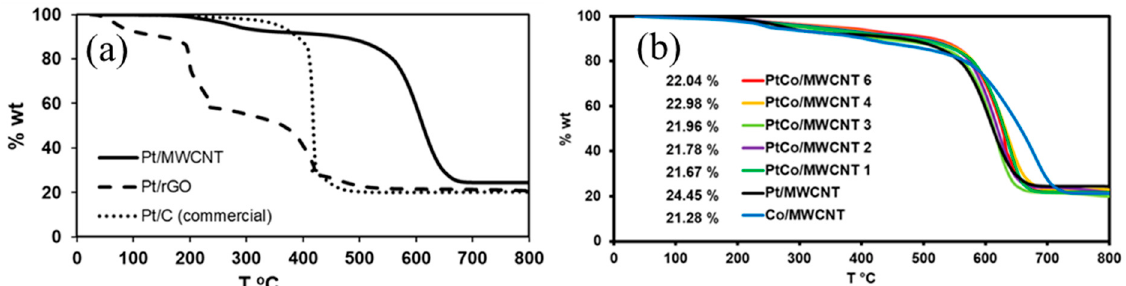
Figure 2. ( a ) Thermogravimetric curves of Pt/MWCNT, Pt/C, and Pt/rGO under air atmosphere. ( b ) Thermogravimetric curves of the PtCo/MWCNT catalysts under air atmosphere; the metal loading mass is inset in the figure.